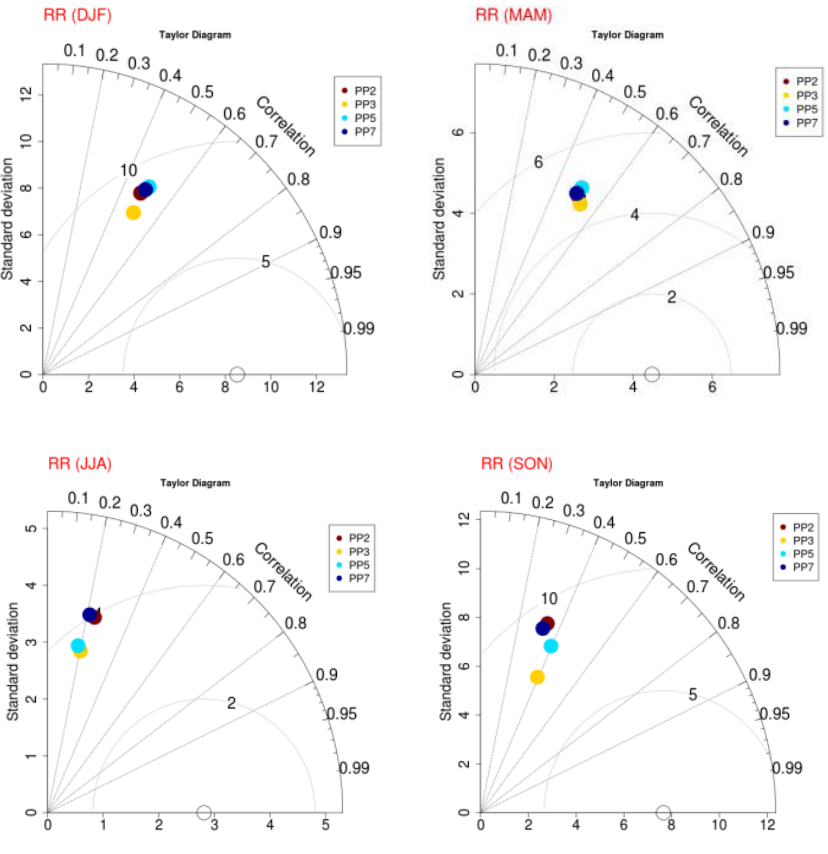
Figure 3. Seasonal Taylor diagrams of the four WRF simulations (PP2, PP3, PP5, PP7) with respect to observed daily precipitation (RR) for the high-resolution domain of Greece (D02).